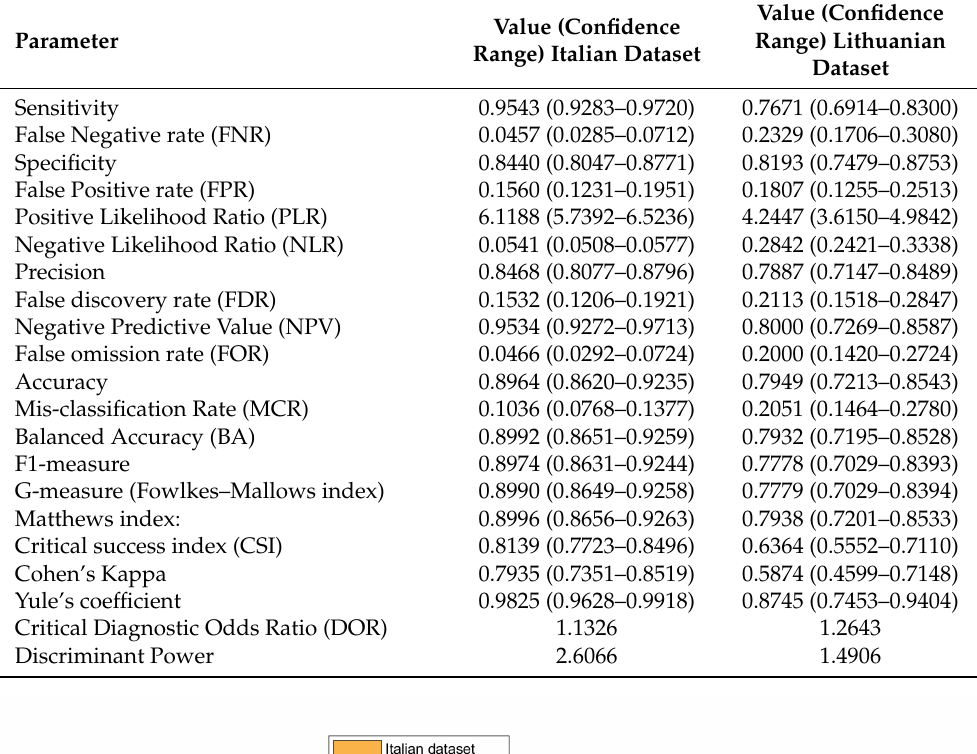
Table 3. Summary of the performance results.